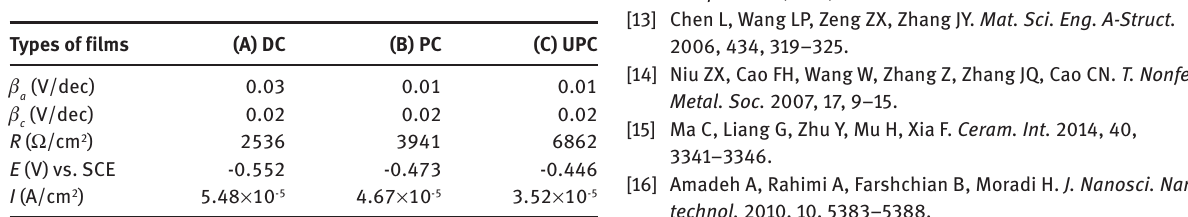
Table 2 Erosion characteristics of Ni-AlN thin films in 3.0 wt.% NaCl